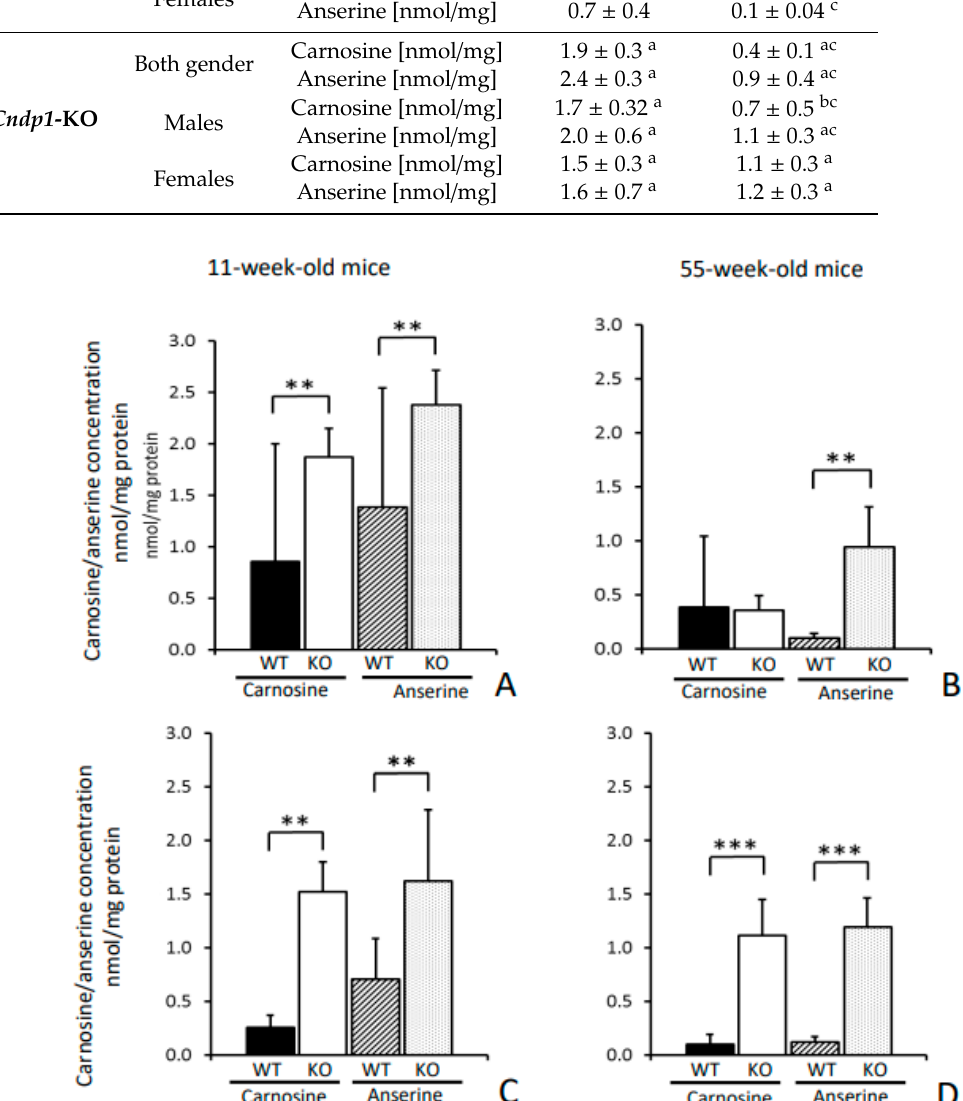
Figure 1. Renal carnosine and anserine concentrations. For male ( A , B ) and female ( C , D ) mice carnosine and anserine concentrations decreased with age and were higher in Cndp1 -KO mice than in WT mice (each n = 4). In 55-week-old male mice ( B ), carnosine concentrations were not different between Cndp1 -KO and WT mice. **: p < 0.01; ***: p < 0.001.